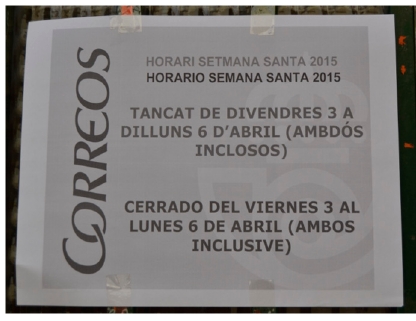
Figure 10. Benasal: Bilingual sign on a post office document .